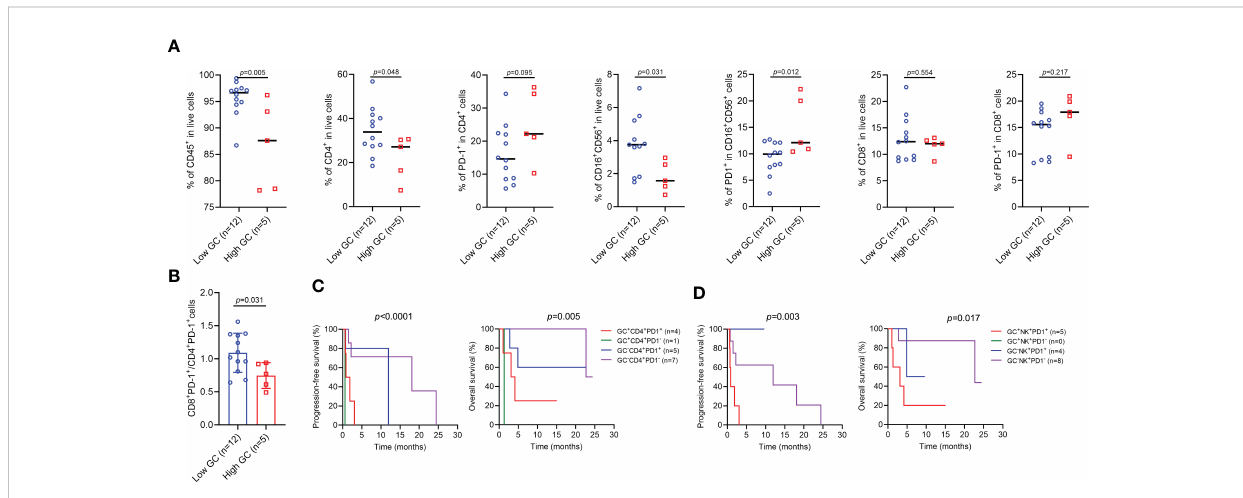
FIGURE 6 The effect of endogenous GC on the percentages of immune cell subgroups in patients with high or low endogenous GC levels. (A) Comparing the percentages of immune cell subgroups in patients with high (n=5) or low (n=12) endogenous GC levels. (B) Comparing the CD8 + PD-1 + to CD4 + PD- 1 + ratio in patients with high (n=5) or low (n=12) endogenous GC levels. (C, D) Kaplan-Meier survival curves for progression-free and overall survival according to the baseline endogenous GC levels and the proportion of cell subgroups.